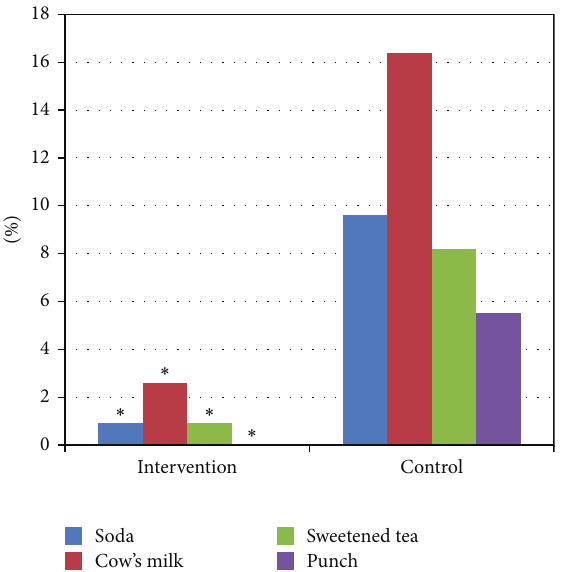
Figure 2: Liquids other than breast milk or formula offered to infants. ∗ Soda: 𝑝 < 0.006 , cow’s milk: 𝑝 < 0.001 , sweetened tea: 𝑝 < 0.014 , and punch: 𝑝 < 0.021 .